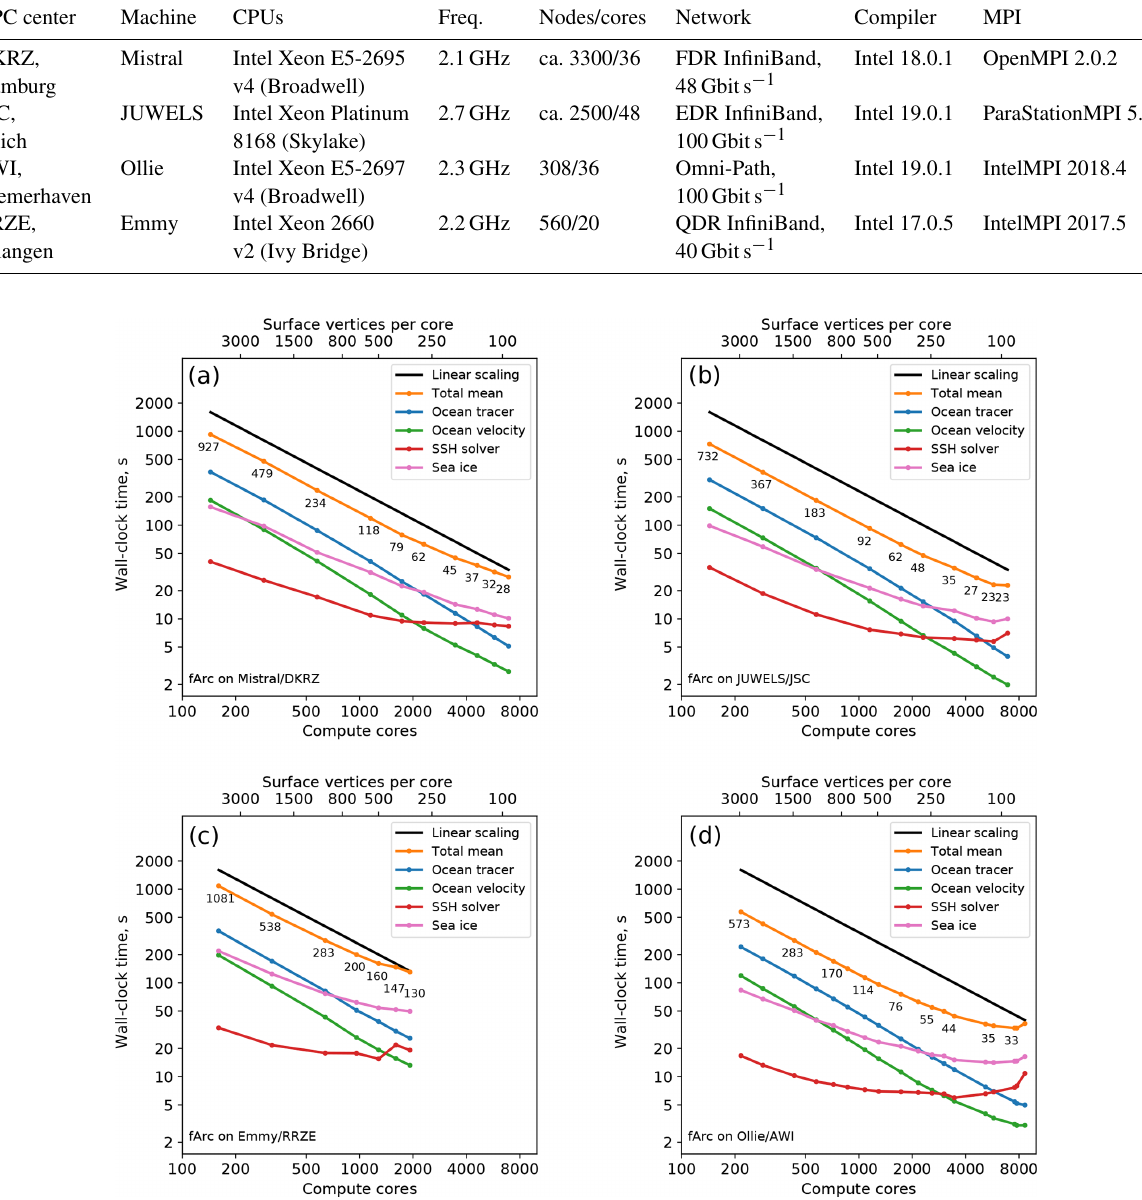
Figure 2. Scaling results for the fArc mesh on Mistral (DKRZ, Hamburg; a ), JUWELS (JSC, Jülich; b ), Emmy (RRZE, Erlangen; c ), and Ollie (AWI, Bremerhaven; d ) compute clusters. The black line indicates linear scaling and the orange line (and the number labels) gives the mean total computing time over the parallel